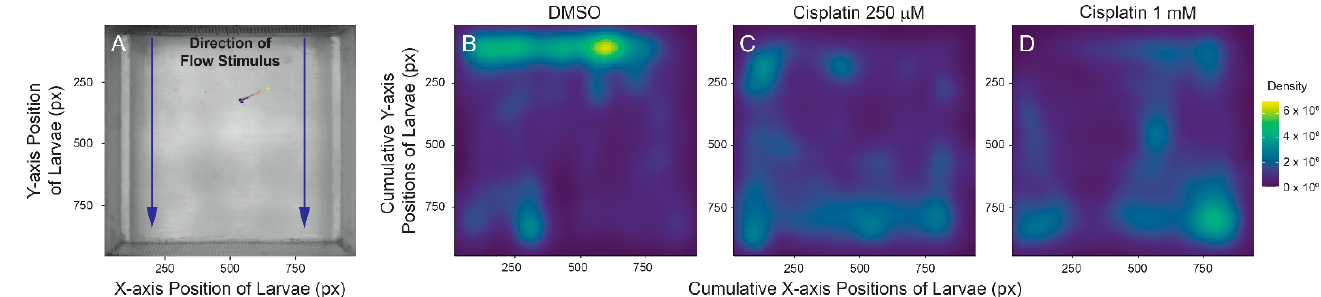
Figure 4. Cisplatin impairs larval ability to station hold in the presence of flow stimulus. ( A ) Top- down view of microflume with overlaying Cartesian coordinate system. Blue arrows indicate direc- tion of water flow. Zero on the y axis indicates area of microflume with the strongest flow. Fish included for scale. ( B – D ) Two-dimensional spatial heat maps of cumulative positioning during flow stimulus indicate that lesioned fish accumulate towards the back of the microflume while DMSO- treated fish successfully station hold against current. n = 8–10 fish. N = 6 trials.